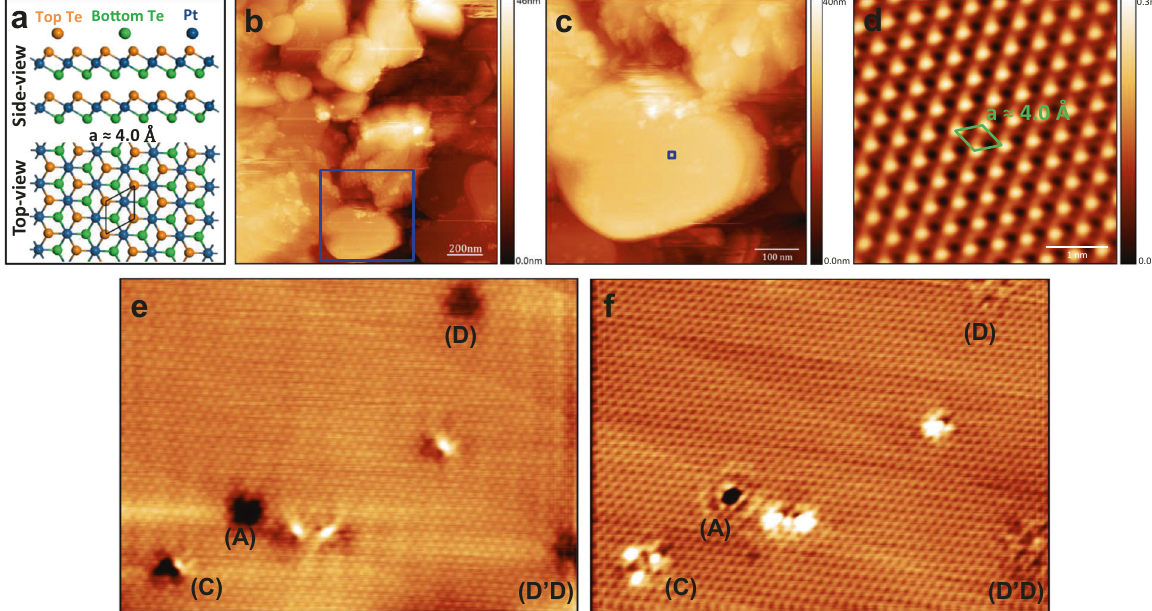
Fig. 1 STM images of the polycrystalline PtTe 2 fi lm. a Schematic view of 1T-PtTe 2 . b Large-scale STM image of the PtTe 2 polycrystalline fi lm (1500 × 1500 nm, V = 1.5 V and I = 80 pA). c STM image exhibits some contaminants present at the upper edge on the surface of the PtTe 2 crystal (600 × 600 nm, V = 1.5 V and I = 60 pA). d STM image showing atomic structure of PtTe 2 in a defect-free area with an interatomic distance of 4.0 ± 0.03 Å (4 × 4 nm, V = 0.7 V and I = 300 pA). e , f STM images of some defects on a polycrystalline PtTe 2 fi lm. e Empty states STM image of the PtTe 2 fi lm (20 × 15 nm, V = 0.85 V and I = 185 pA). f Filled states STM image of the PtTe 2 fi lm (20 × 15 nm, V = − 0.85 V and I = 185